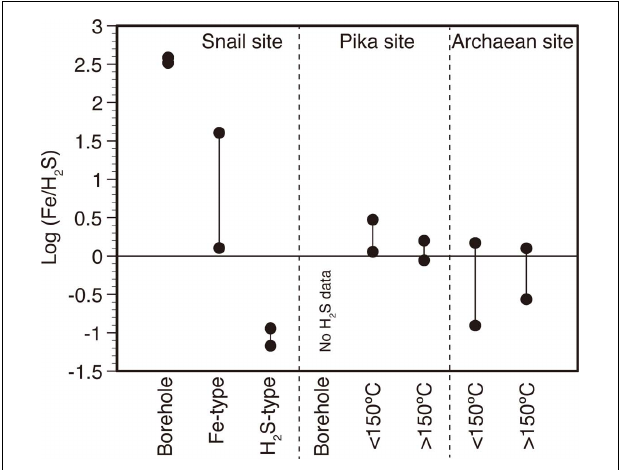
FIGURE 2 |The ratio of Fe to H 2 S in fluid samples.